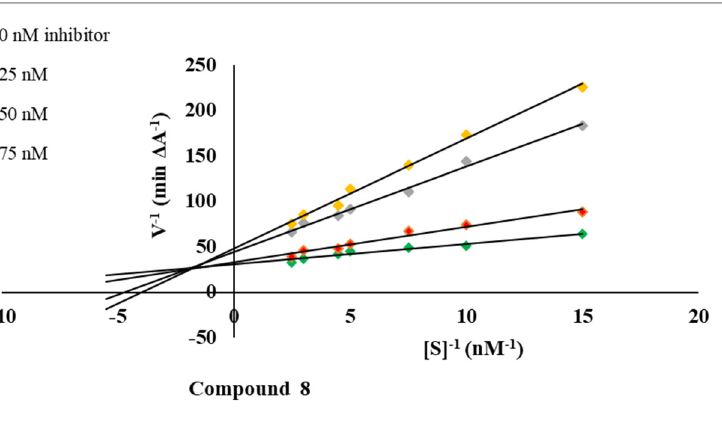
Figure 4. Lineweaver-Burk reciprocal plots for the AChE inhibition by compound 8